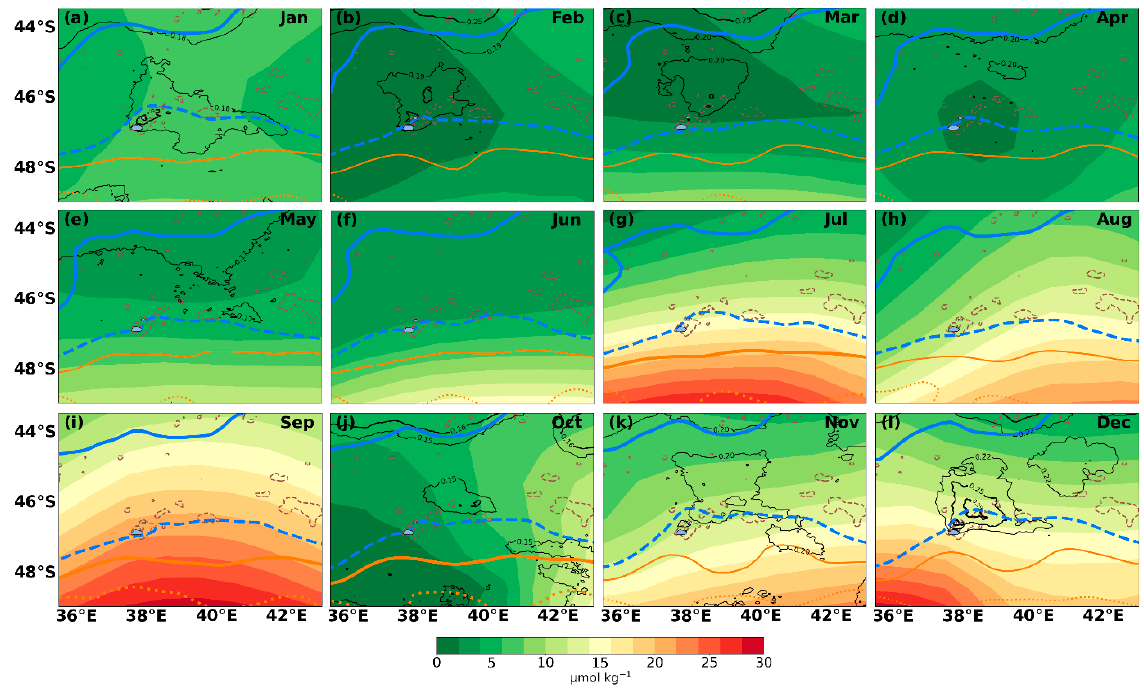
Figure 8. ( a – l ) Monthly (January to December) World Ocean Atlas 2018 climatology of silicate (µmol kg − 1 ). The black contours indicate the lowest and highest chla (mg m − 3 ) concentrations that formed unique closed contours in our region of interest (0.18 and 0.25 in January; 0.19 and 0.25 in February; 0.20 and 0.25 in March; 0.20 in April; 0.17 in May; 0.15 and 0.16 in October; 0.20 and 0.25 in November; 0.22, 0.25, and 0.29 in December). The dashed brown contours indicate the 1000 m isobath. The solid and dashed thick blue lines show the climatological mean positions of the middle (M-SAF) and southern (S-SAF) branches of the sub-Antarctic Front, respectively. The solid and dotted thick orange lines illustrate the climatological mean positions of the northern (N-APF) and middle (M-APF) branches of the Antarctic Polar Front,